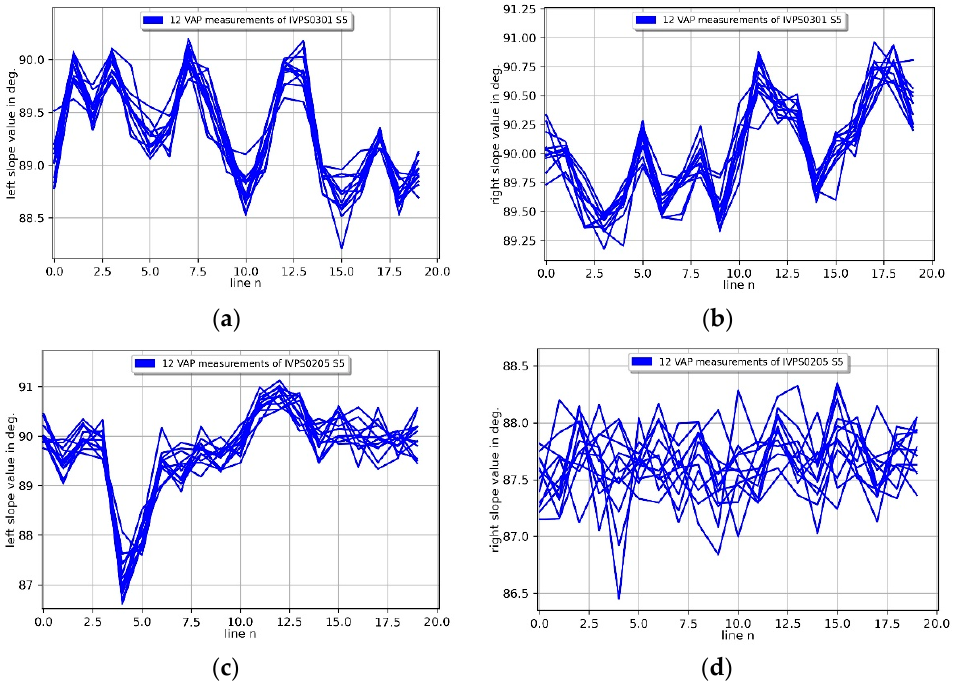
Figure 13. Repetition side wall angle measurements of two orthogonal mounted IVPS100-PTB structures (IVPS0301 ( a , c ) and IVPS0205 ( b , d )). The left side wall angles are shown in ( a , c ) and the right side wall angles in ( b , d ) over 20 lines.